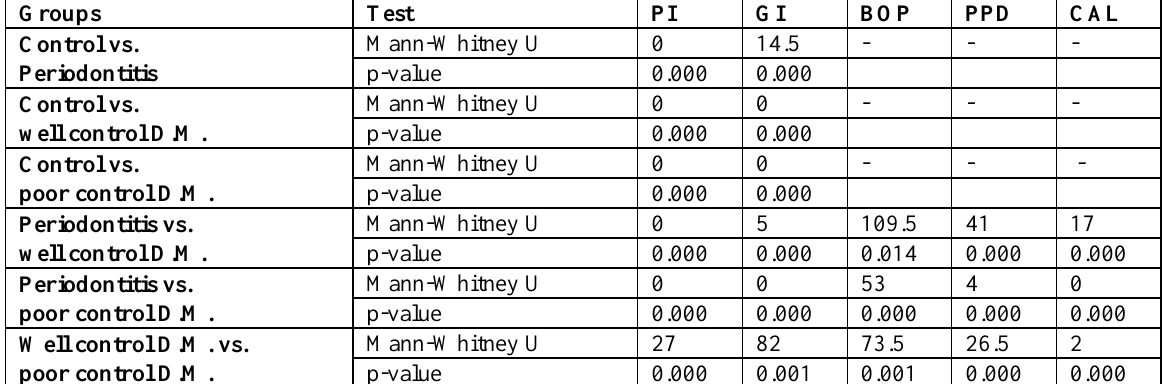
Table 2: Comparison between each two groups in clinical parameters